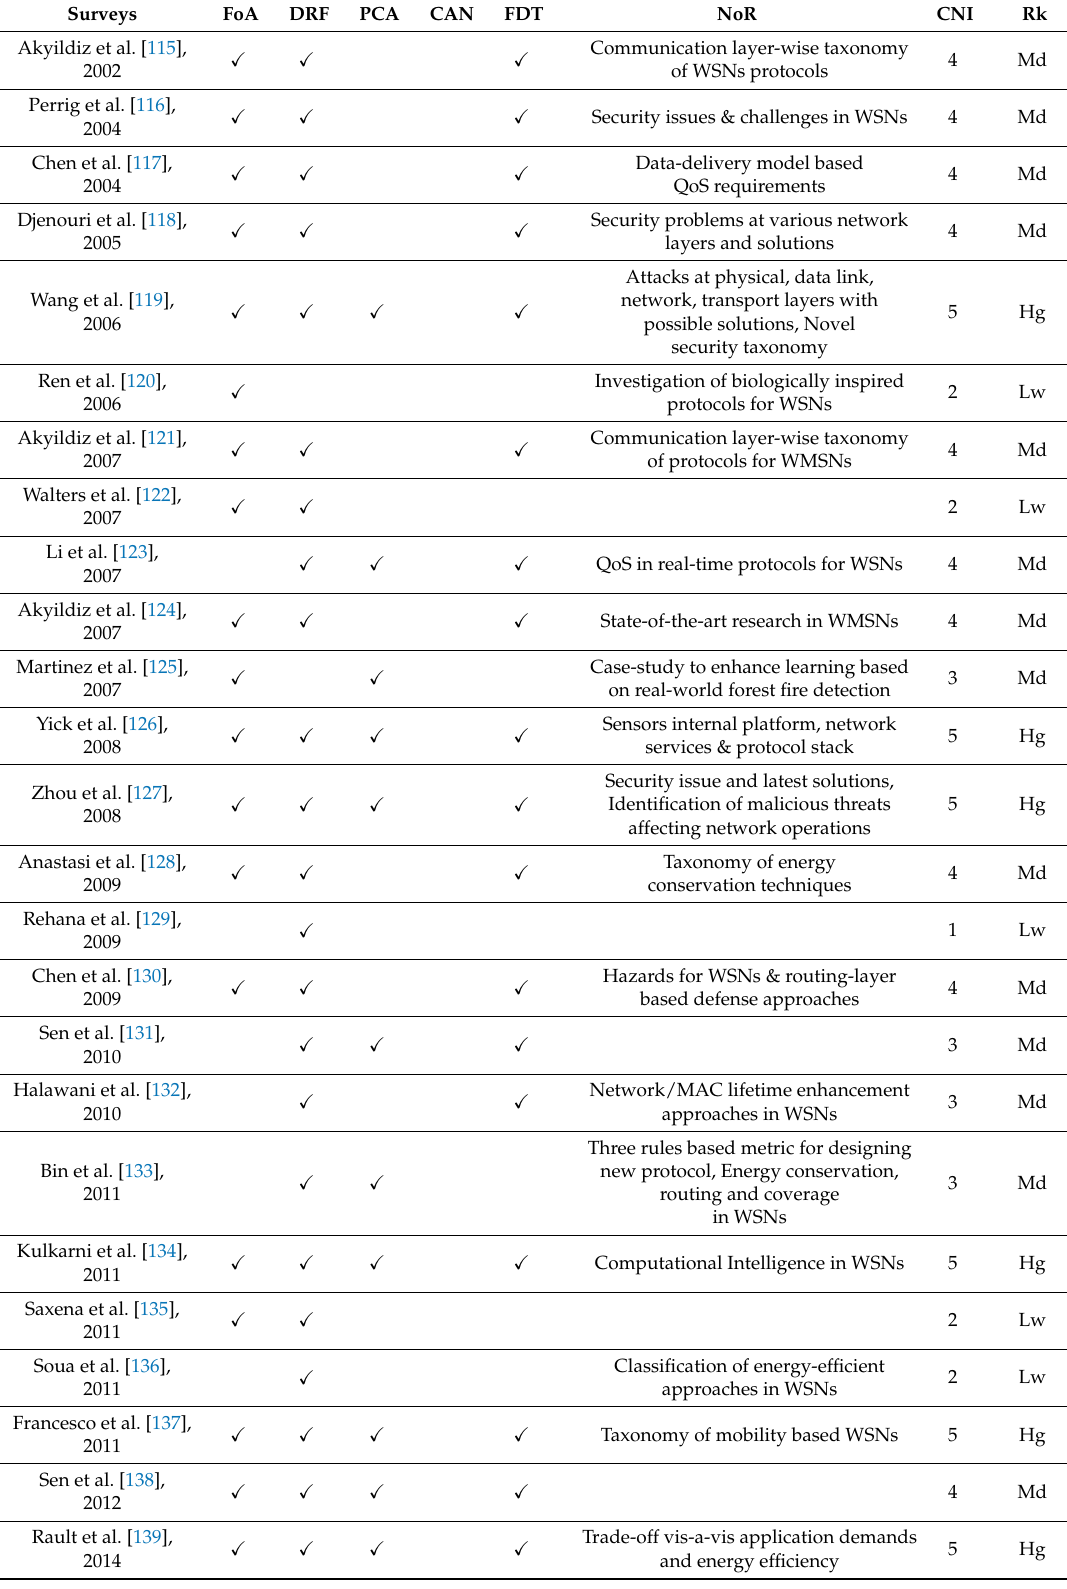
Table 3. Design analysis of surveys (with partial emphasis on routing in WSNs) under GSDF.